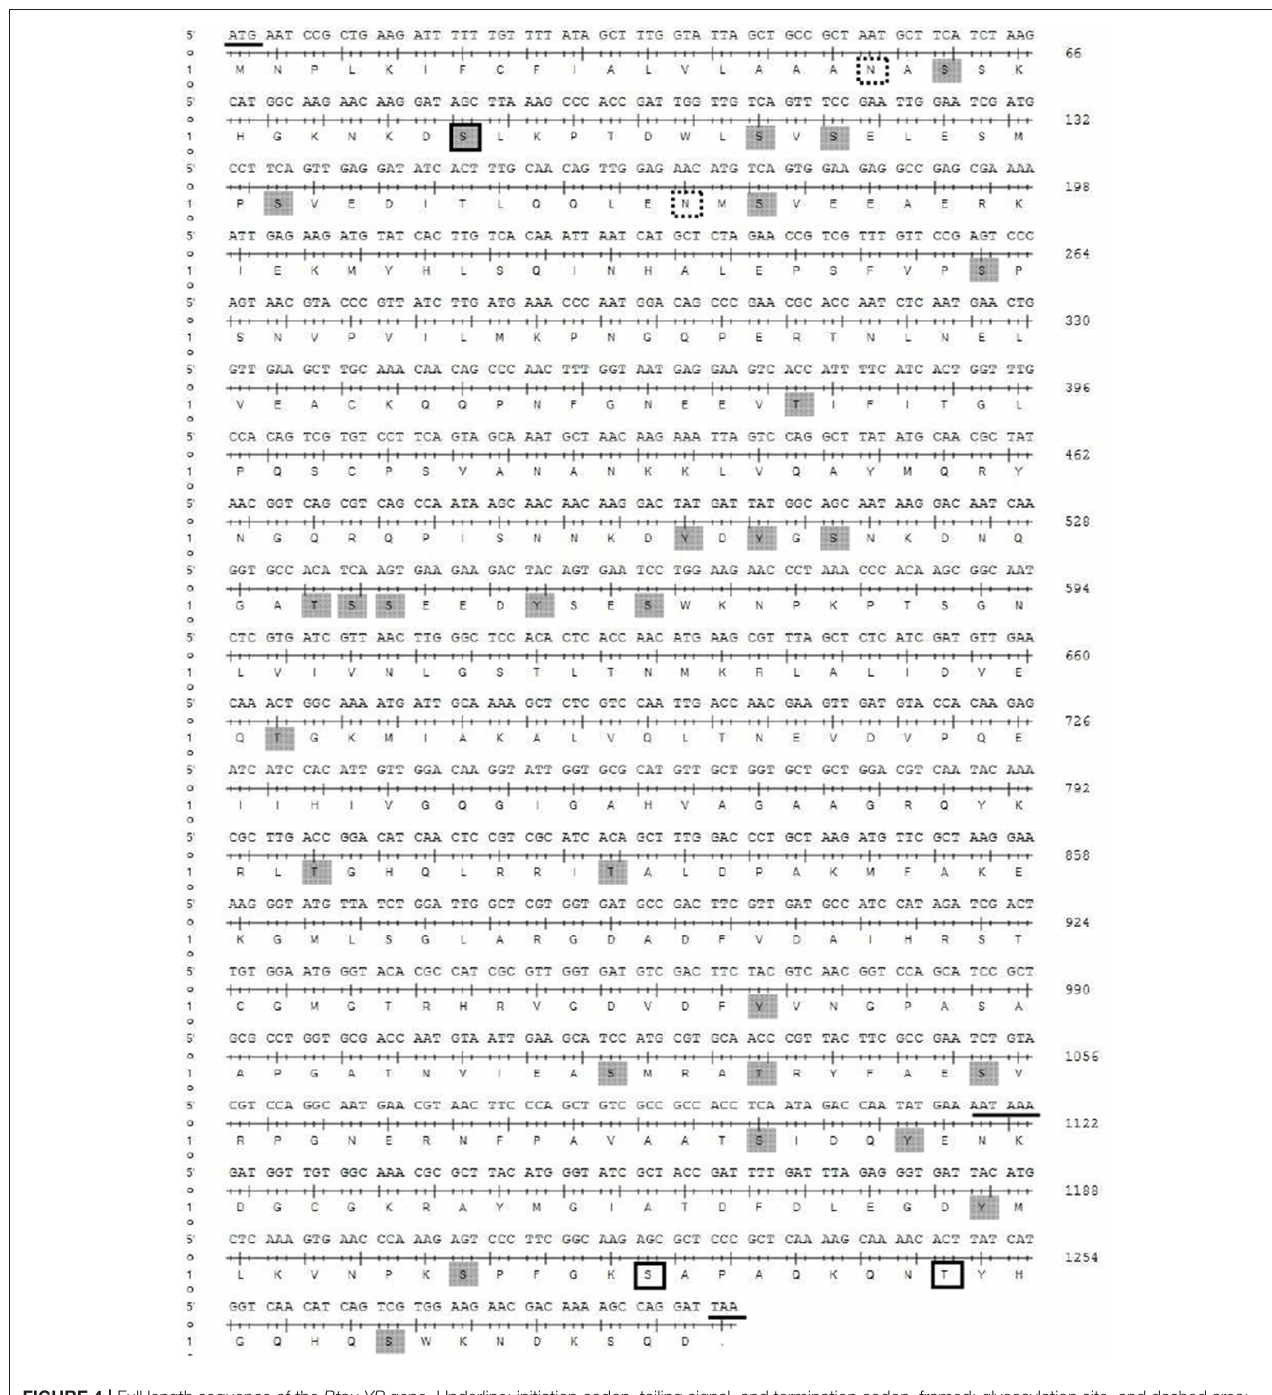
between 150 and 200 Gy to the pupae stage of B. tau could ensure sterilization in a control